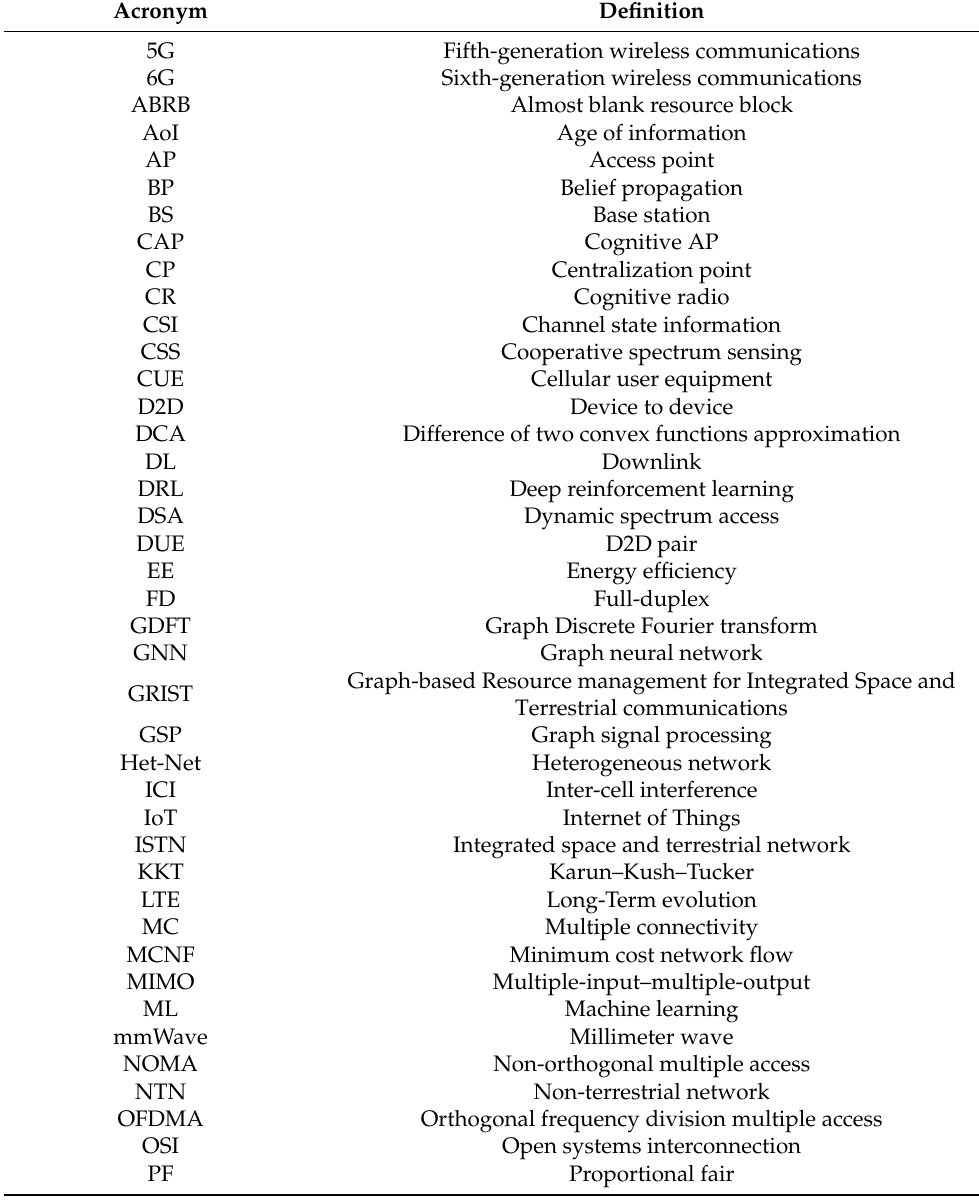
Table 1. Table of